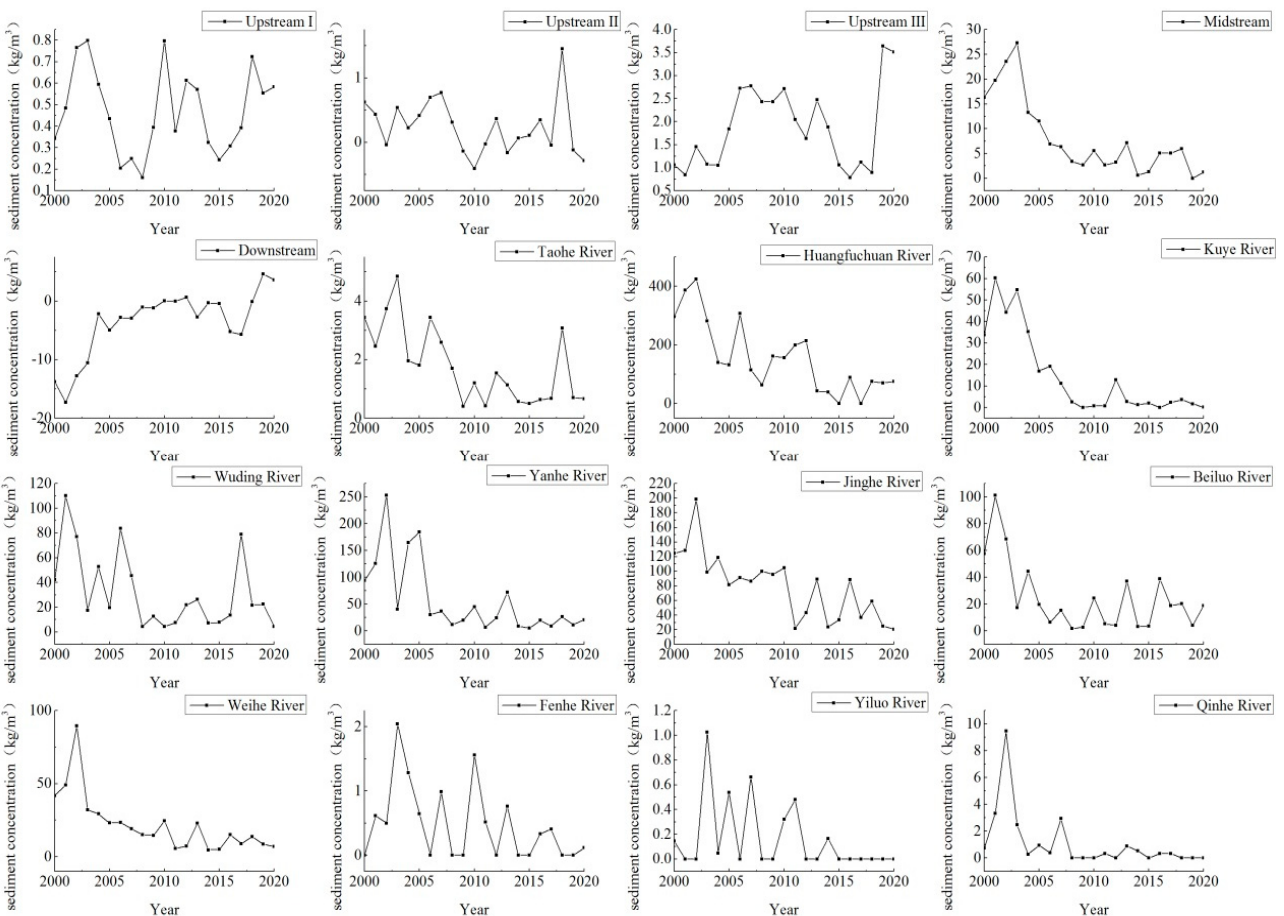
Figure 8. Changes in sediment concentration in the main stream and tributaries of the Yellow River basin; this figure includes the change in sediment concentration in each division of the main stream and tributaries.